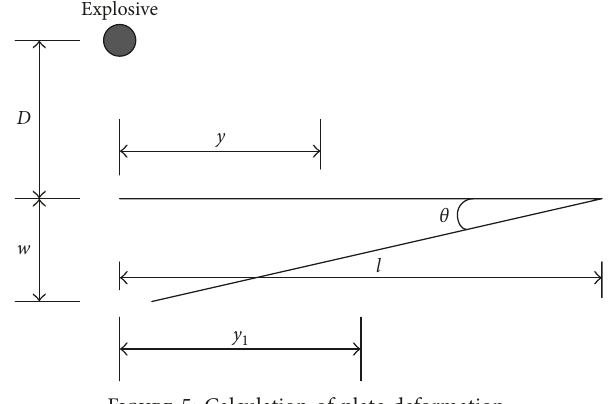
Figure 5: Calculation of plate deformation.